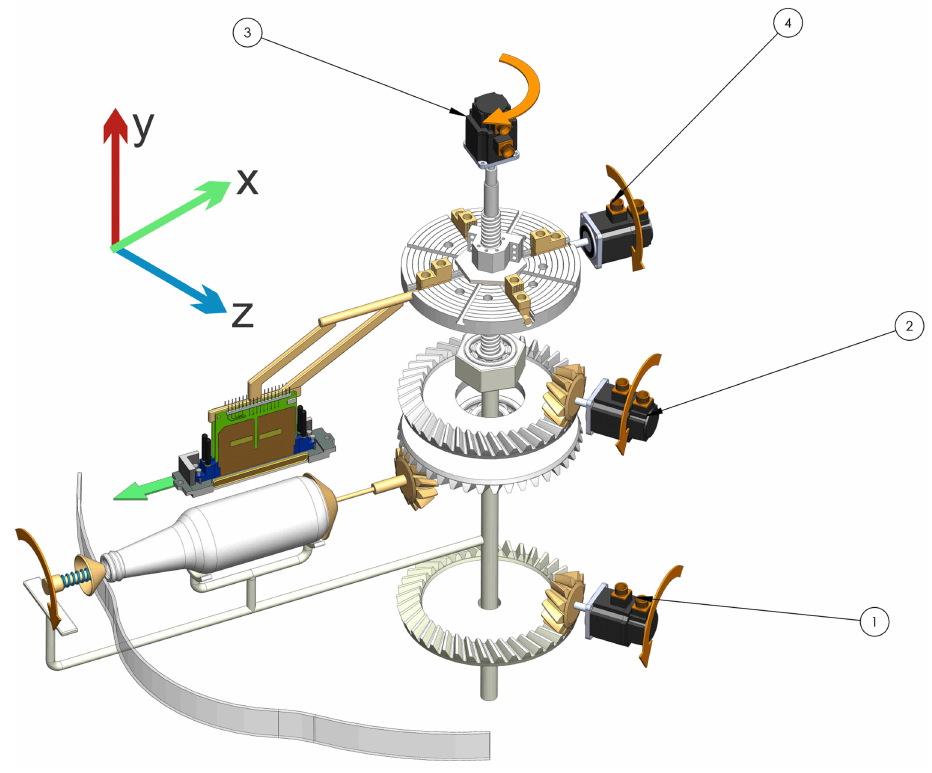
Figure 10. Scheme topology